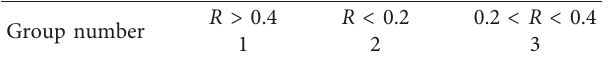
Table 4: Different groups of piers based on pier height to span length